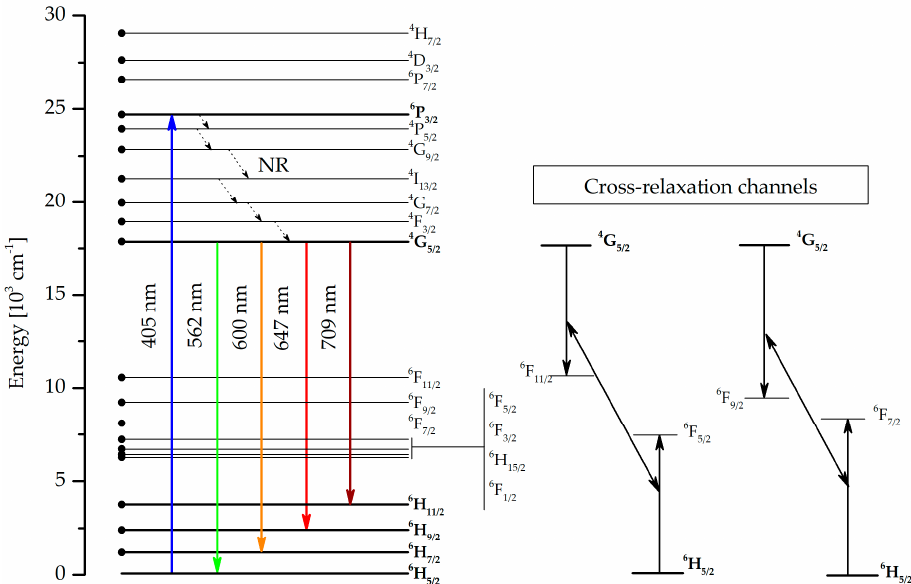
Figure 4. Energy level diagram of Sm 3+ with emission and cross-relaxation channels [18,19].